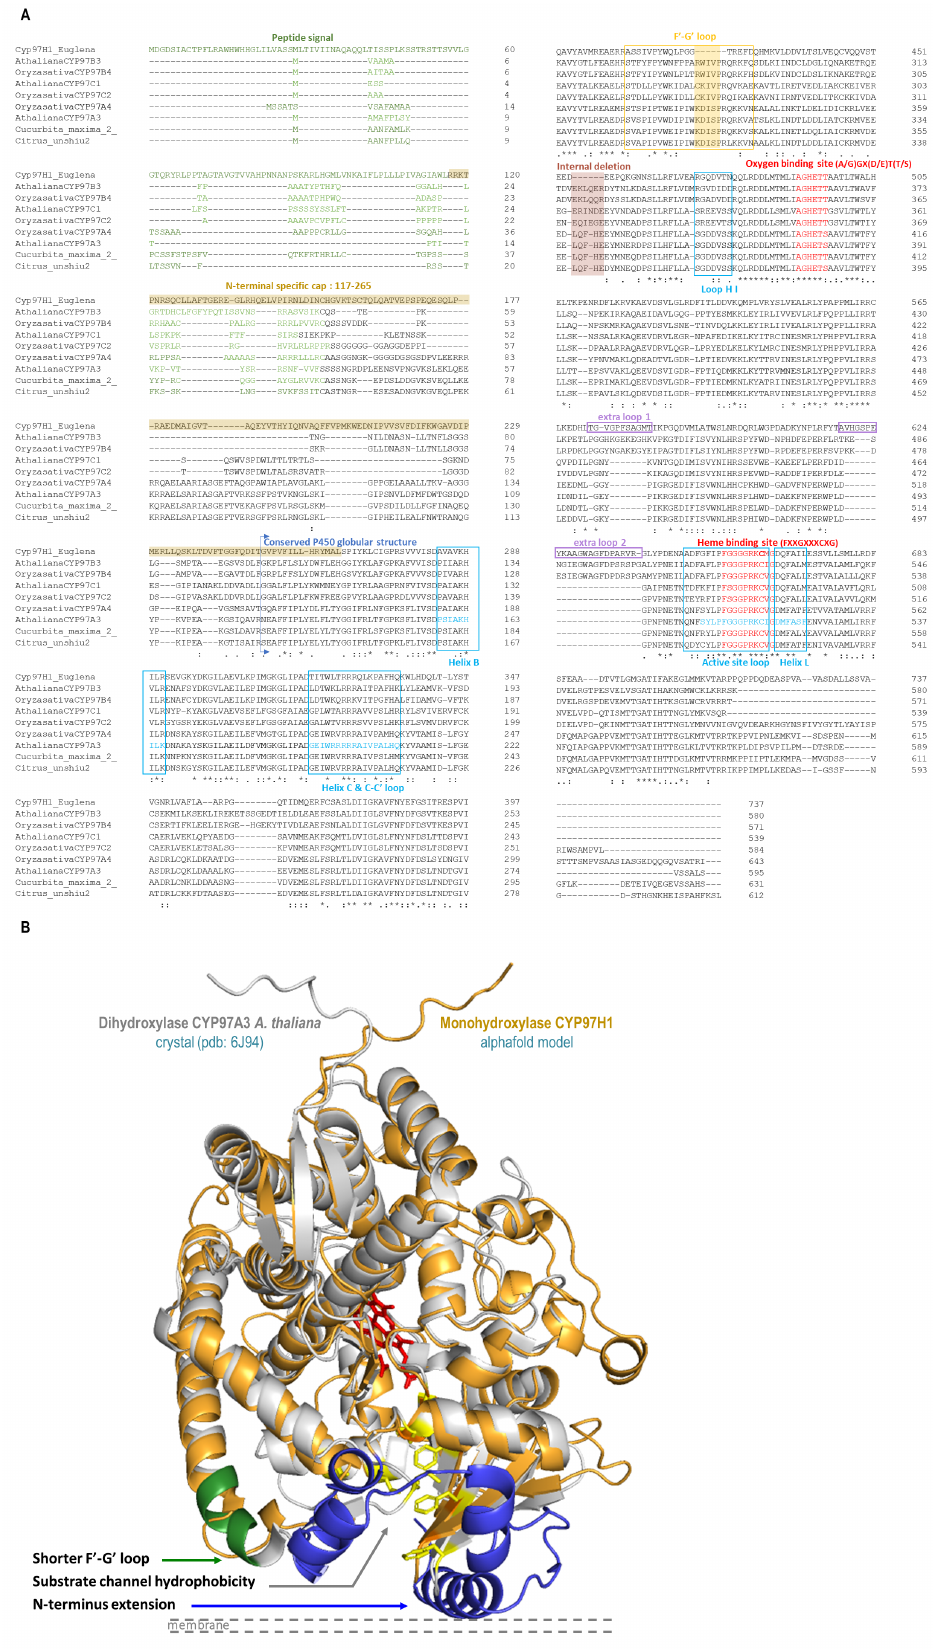
Figure 2. ( A ): CYP97 alignment and key P450s domains of CYP97H1 from E. gracilis , CYP97A3, CYP97B3, CYP97C1 from A. thaliana , CYP97A4, CYP97B4, CYP97C2 from O. sativa , Ct CYP97 from C. unshiu